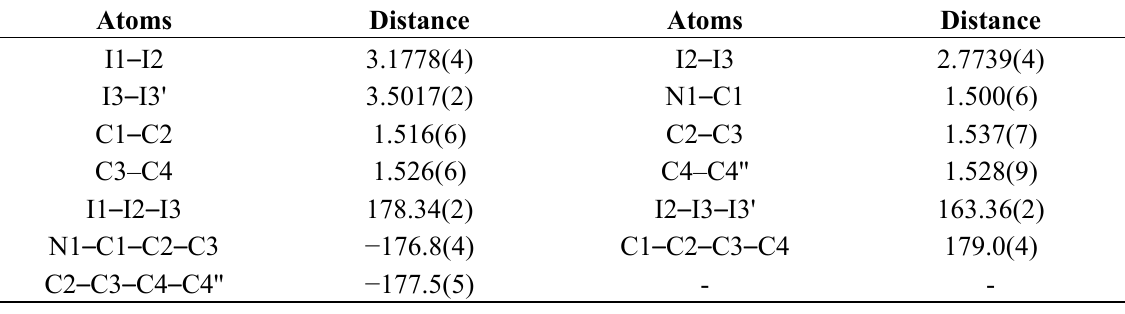
Table 1. Selected bond lengths [Å] and angles [°] for 18dbt .